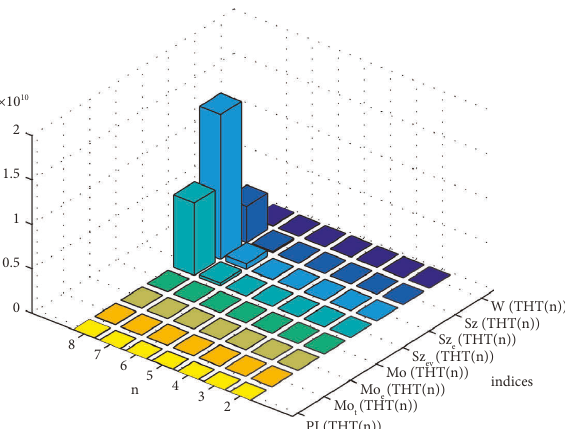
Figure 7: Graphical representation of numerical values of degree- based